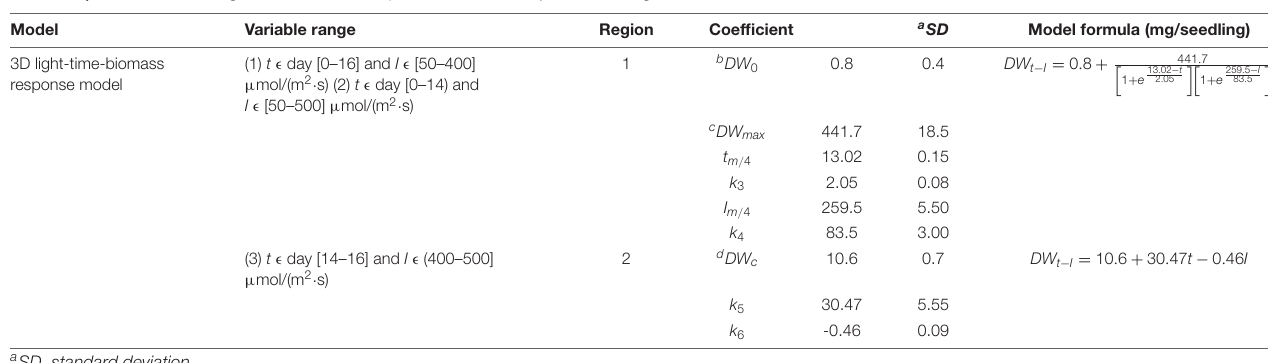
TABLE 5 | The selected 3D light-time-biomass response model of choy sum seedling. Model Variable